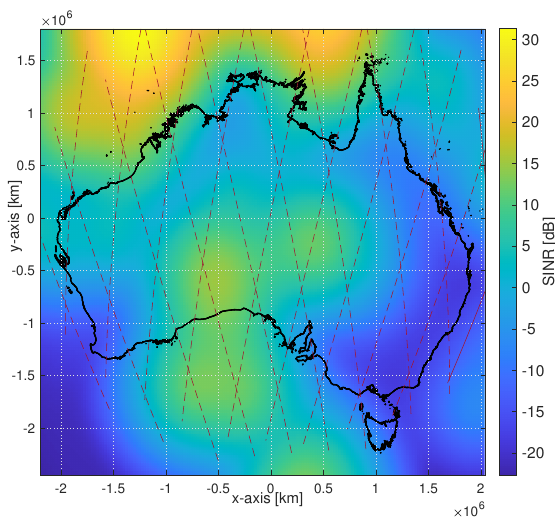
Figure 7. Average Uplink SINR of Australia over a